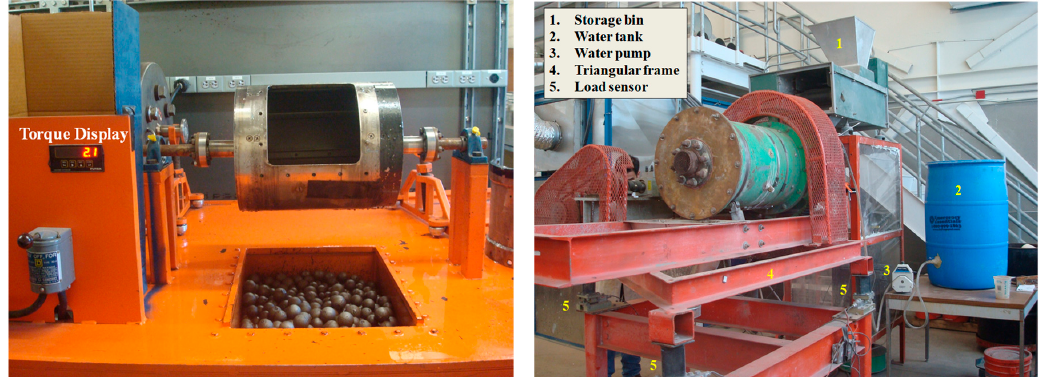
Figure 1. Bench-scale mill (left) and pilot-scale continuous ball mill (right).